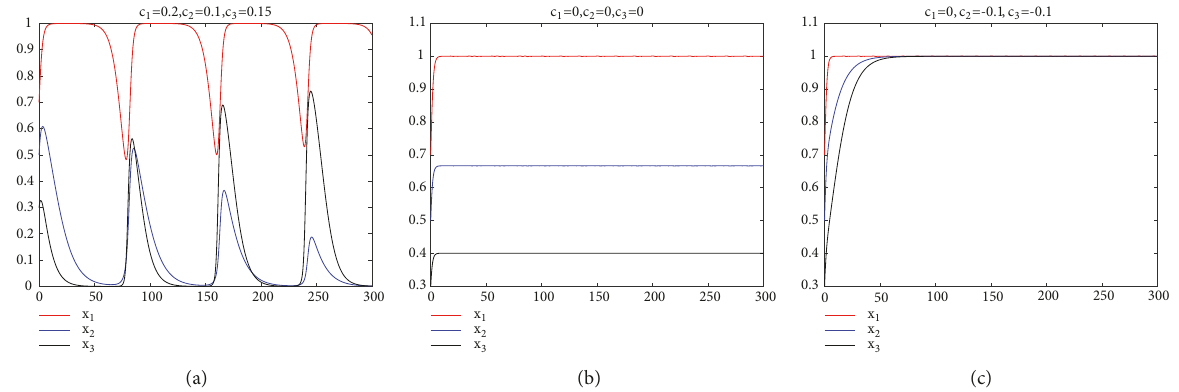
Figure 3: Time series graph of players’ strategy selection probability when 𝑐 1 ,𝑐 2 , 𝑐 3 become smaller simultaneously. (𝑥 1 , 𝑥 2 , 𝑥 3 )| 𝑡=0 = 𝑃 (0.7,0.5, 0.3) 1